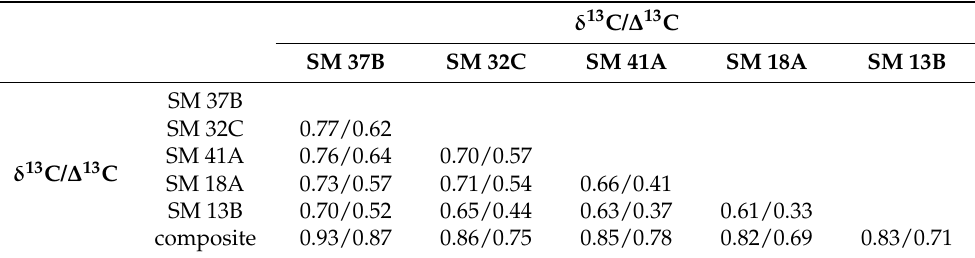
Table 2. Correlations between tree-ring cellulose δ 13 C and ∆ 13 C time series.